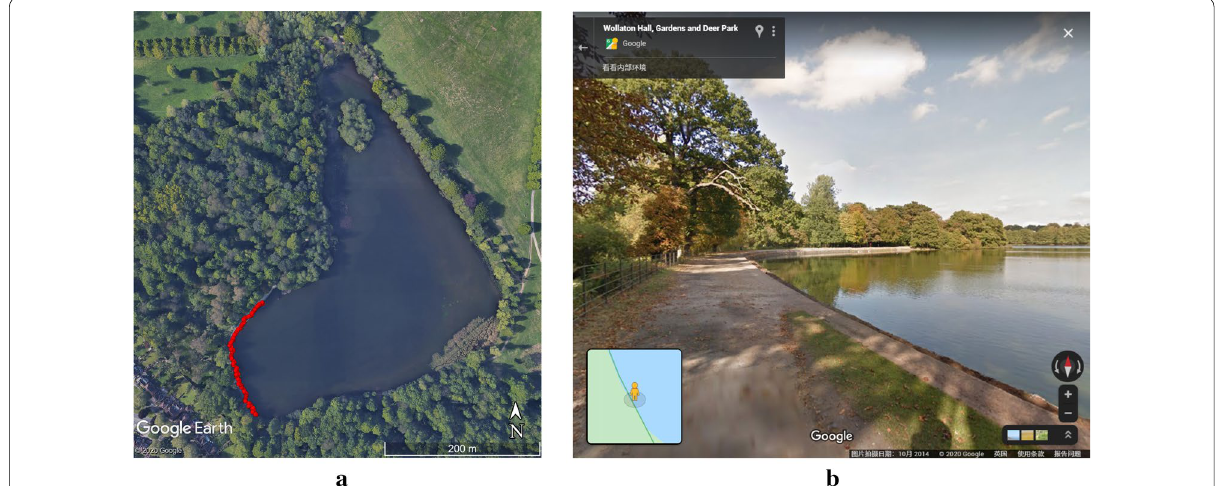
Fig. 22 a A semi-open area and b its actual view in the kinematic scenario